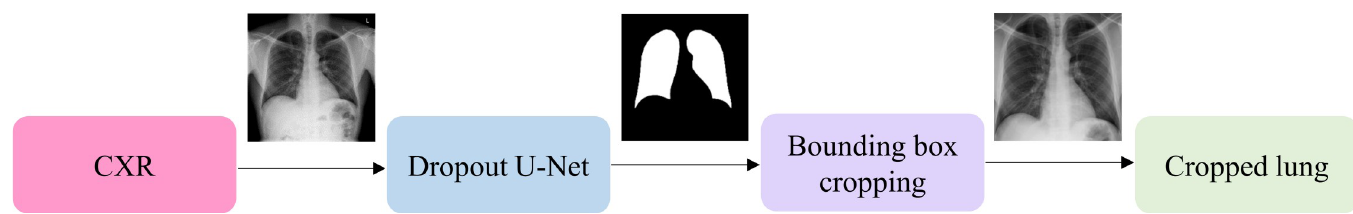
Fig 2. Segmentation workflow showing UNet-based mask generation and lung ROI